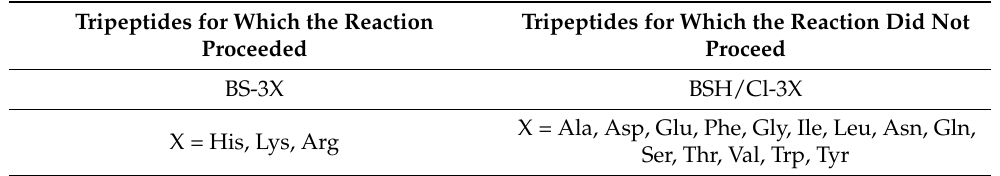
Table 2. Table 1. Amino acid residues contained in chloroacetyl-modified tropeptides and whether the reaction with BSH proceeded with them.